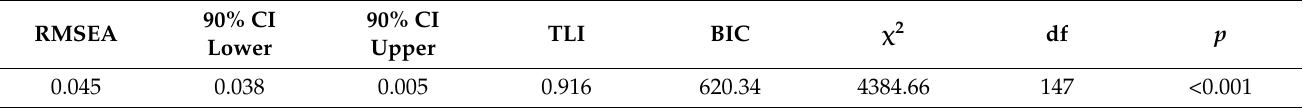
Table 5. Model fit statistics for EFA.